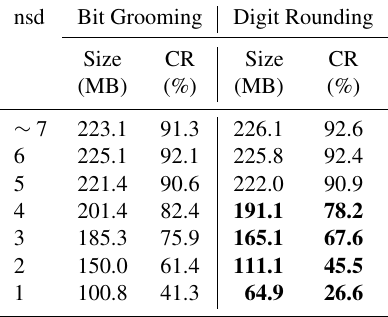
Table 4. Comparison of the Bit Grooming and Digit Rounding al- gorithms for the compression of a MERRA dataset. Shuffle and Deflate (level 1) are applied. The compression ratio (CR) is de- fined by the ratio of the compressed file size over the reference data size (244.3MB) obtained with Deflate (level 5) compression. Bit Grooming results are extracted from Zender (2016a). Bold values indicate where Digit Rounding performs better than Bit